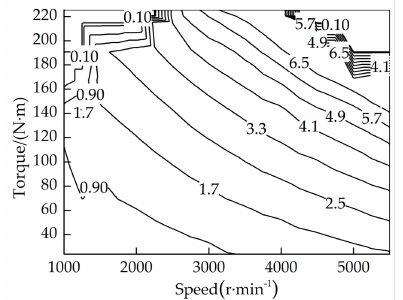
Figure 3. Fuel consumption rate map (unit: g/s).